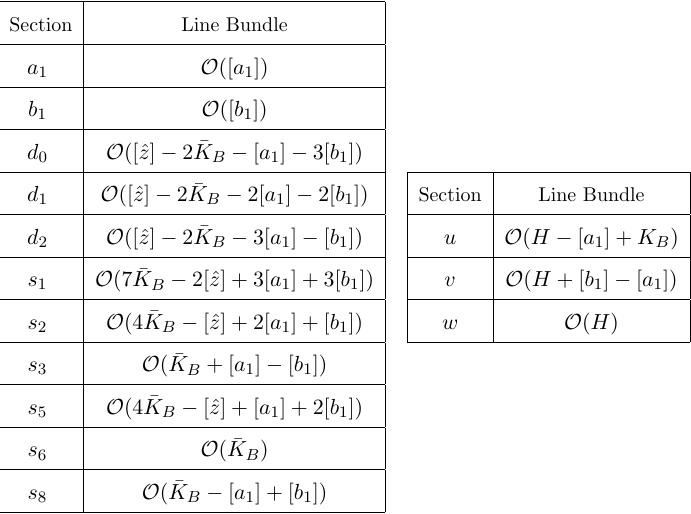
Table 5 . Left: the base sections and their corresponding line bundle classes. Right: the classes for the sections in the toric ambient space P F 1